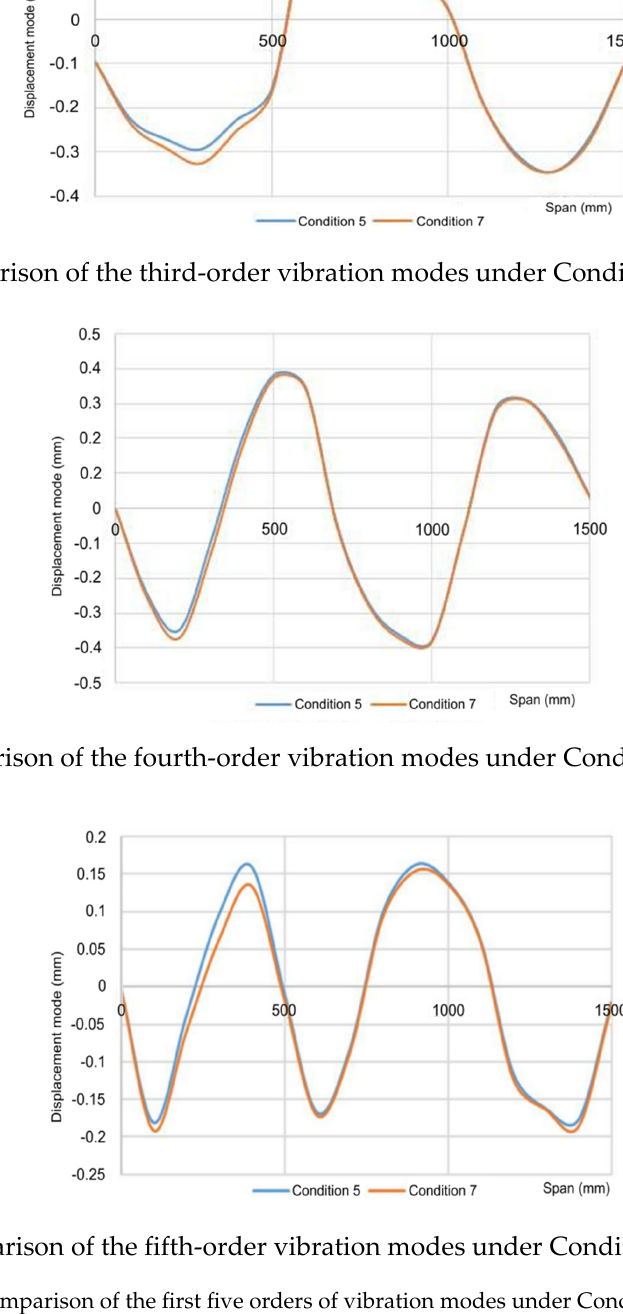
Figure 13. Comparison of the first five orders of vibration modes under Conditions 5 and 7. The comparison results of displacement modes under Condition 5 (stiffened and nondamaged) and Condition 8 (stiffened and double-damage) are shown in Figure 14.